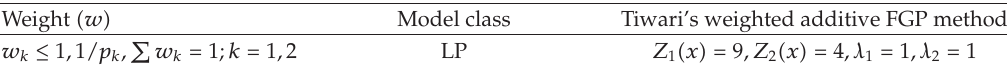
Table 9: Solution of Tiwari’s weighted additive FGP